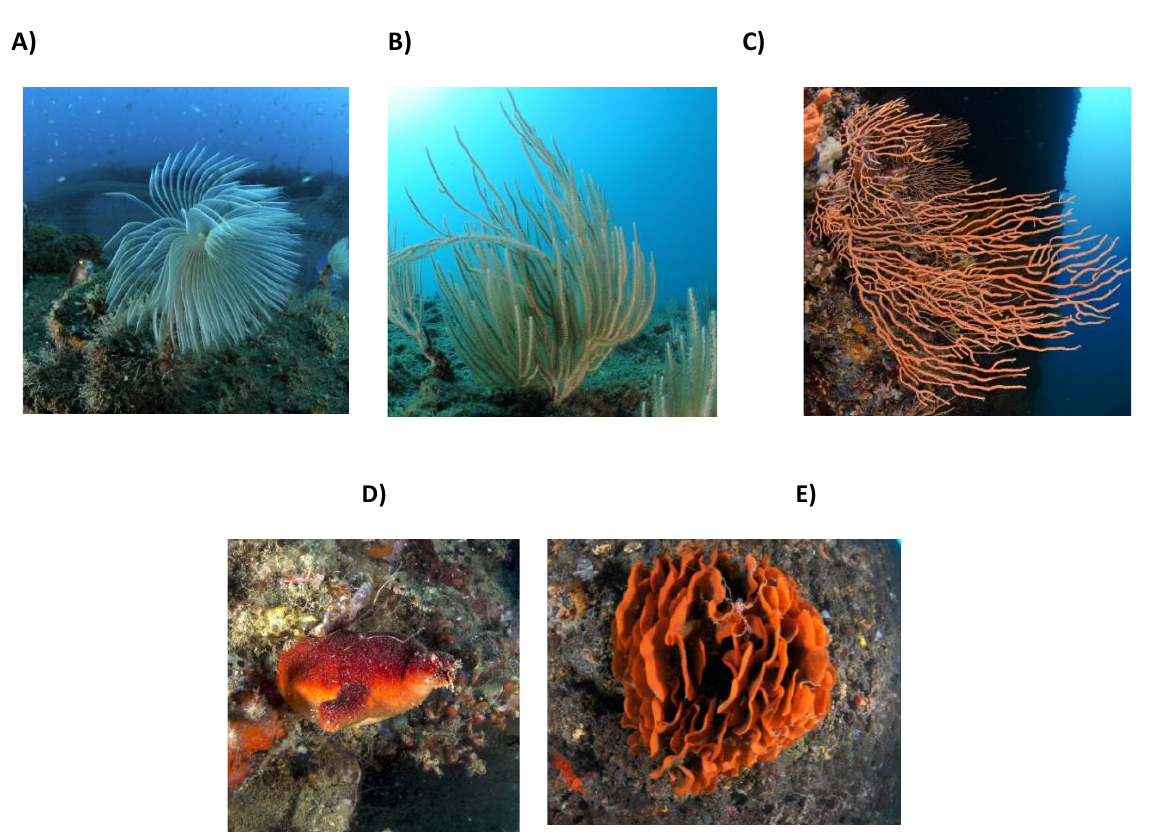
Figure 2: Photographs of the five species inventoried on AR a) Sabella spallanzanii, b) Eunicella singularis, c) Leptogorgia sarmentosa, d) Halocynthia papillosa and e) Pentapora fascialis; all © Blouet sylvain